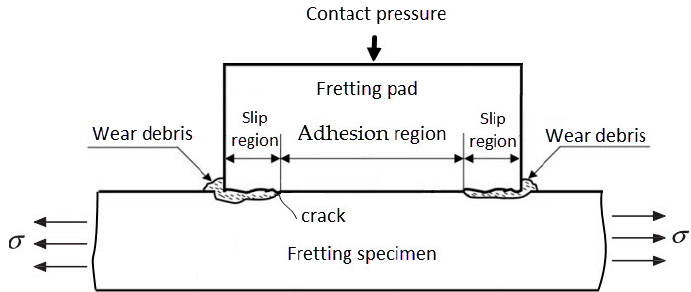
Figure 8. Schematic view of the contact region.